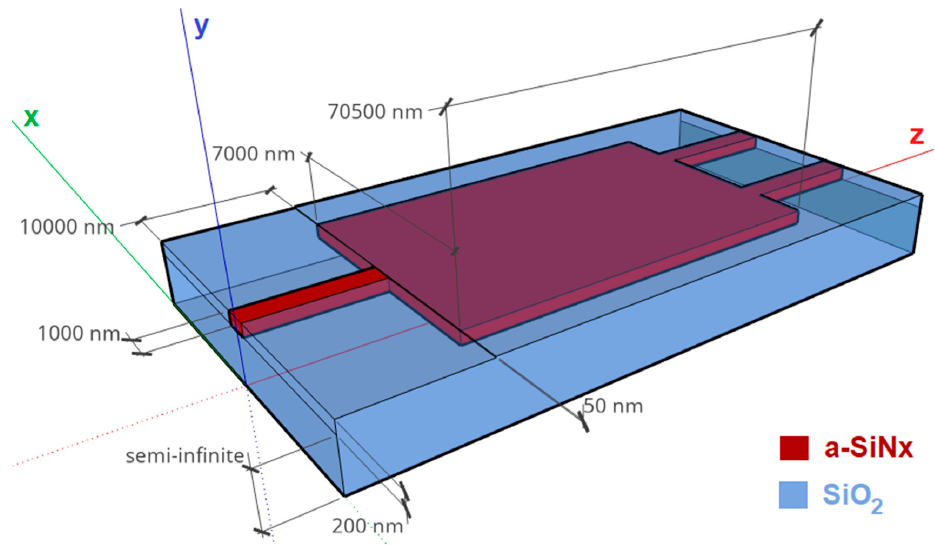
Figure 1. Diagram of simulated MMI structure and involved dimensions.